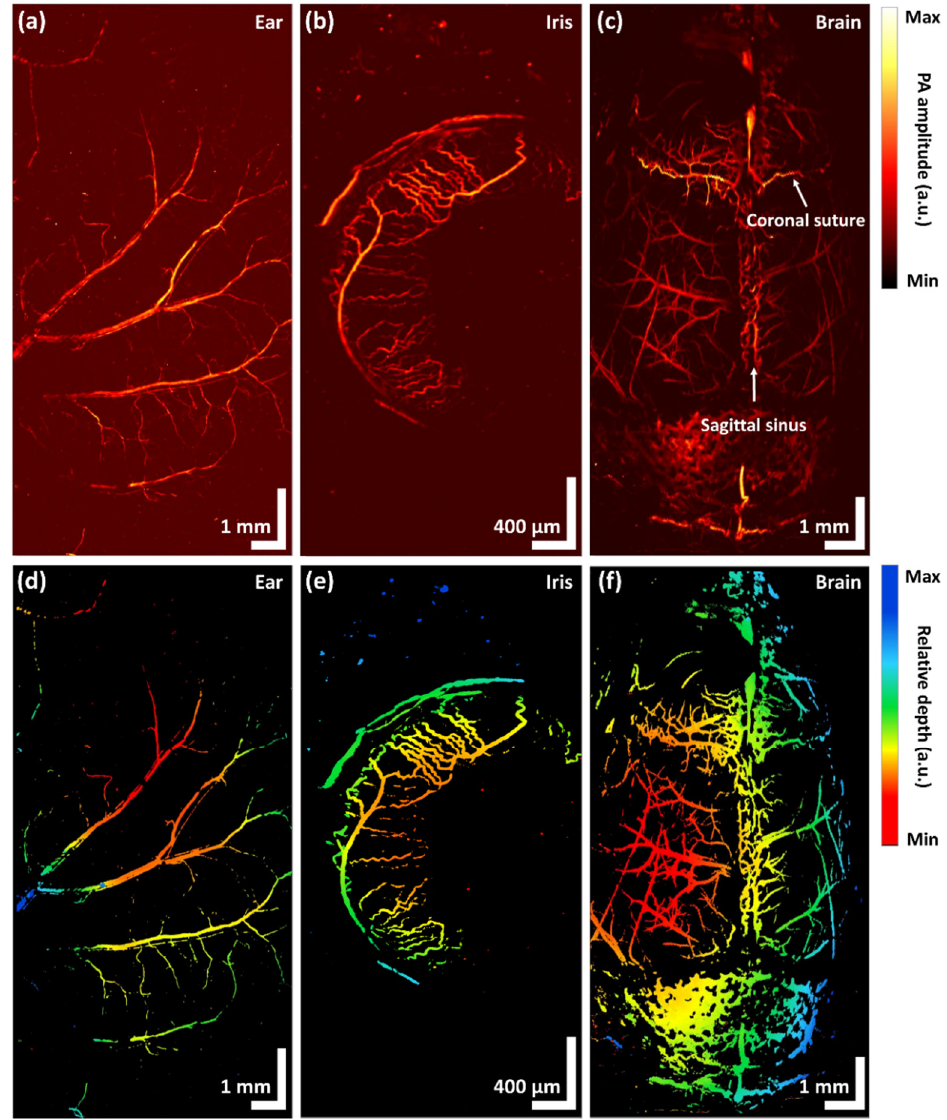
Figure 4. In vivo PA MAP images of micro-vascular maps using WP-GVS-HH-PAM in mouse ear, iris, and brain, respectively. ( a – c ) PA signal intensity-based MAP images. ( d – f ) Depth-encoded PA MAP images.